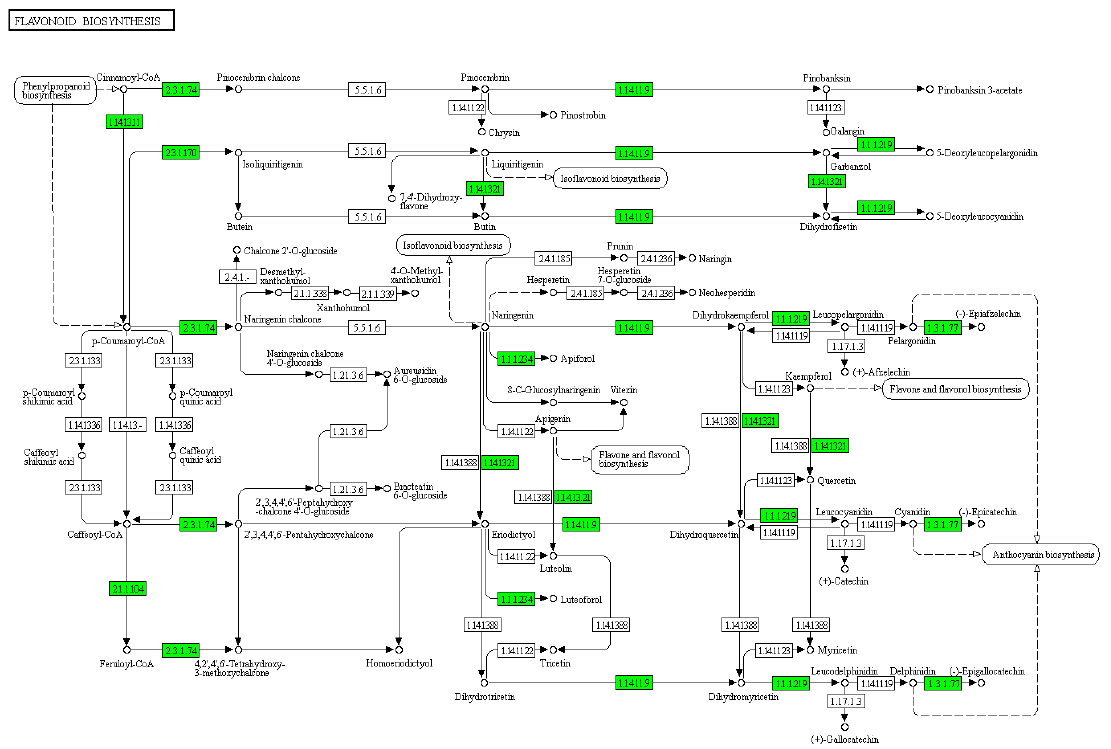
Figure 5. KEGG Pathway analysis of flavonoid biosynthesis 75 h after self- and cross-pollination in C. oleifera . The green color indicated decreased protein abundances level in self-pollinated pistils compared with cross-pollinated pistils.